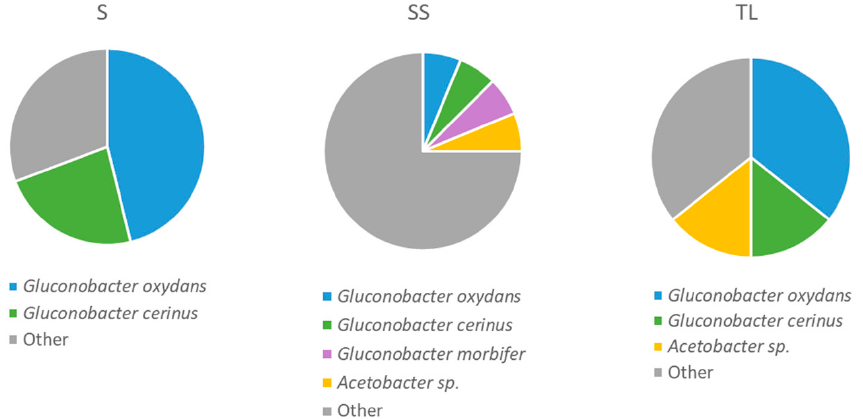
Figure 7. Proportion of AAB species at 24 h after vatting in the different inoculation strategies (SS: spontaneous sulfite, S: spontaneous without SO 2 , TL: inoculation with T. delbrueckii / L. thermotolerans at vatting without SO 2 ).